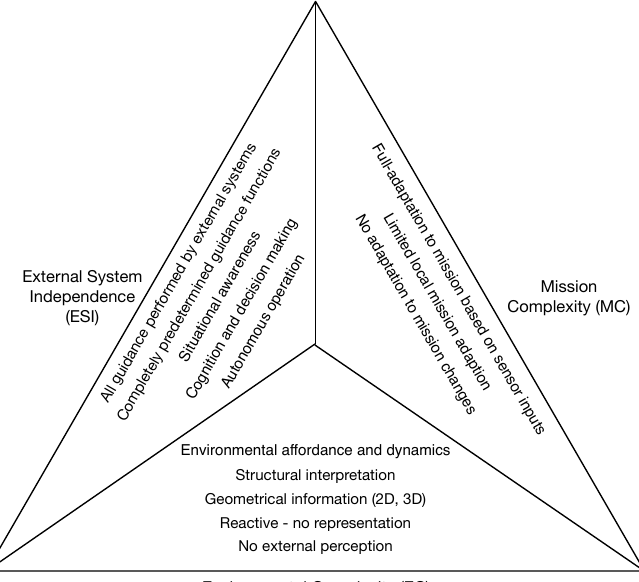
Figure 3. The autonomy levels for unmanned systems (ALFUS) framework [6] applied to snake robot perception-driven obstacle-aided